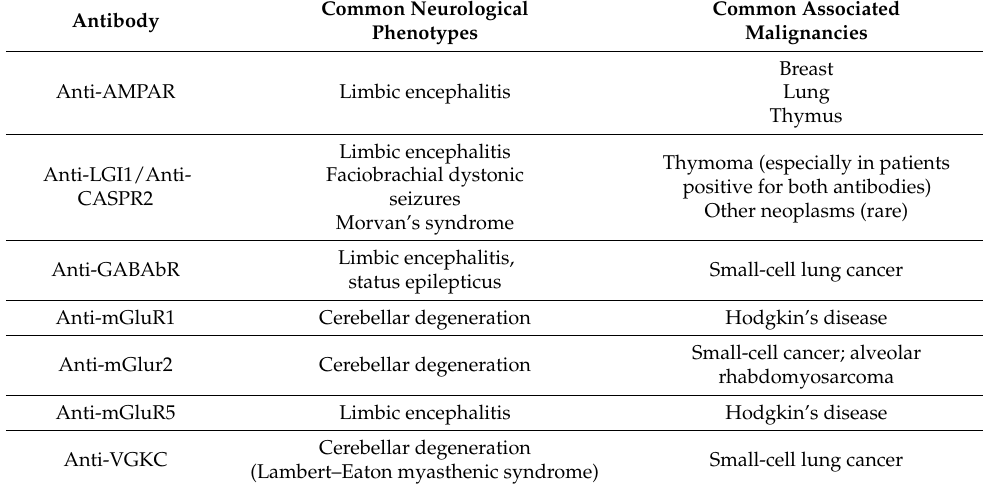
Table 2. Major paraneoplastic onconeuronal antibodies reactive with neuronal membrane antigens. Adapted from Galli, J.; Greenlee, J. Paraneoplastic Diseases of the Central Nervous System [7].